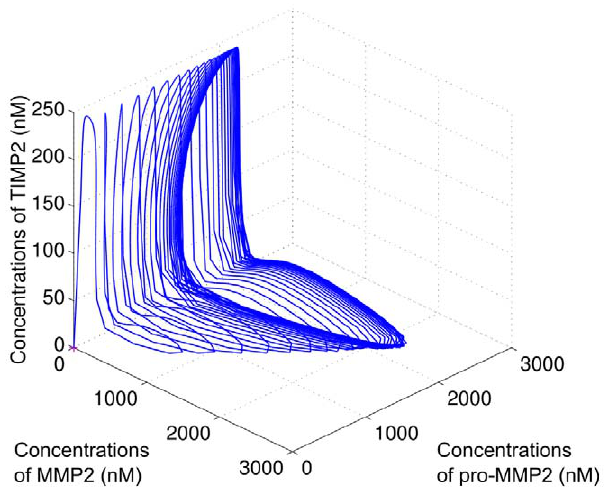
Figure 9. Limit cycle in the space ( M P that the phases of T 2 and M 2 are in opposition: M 2 is low when T 2 is high and vice-versa.